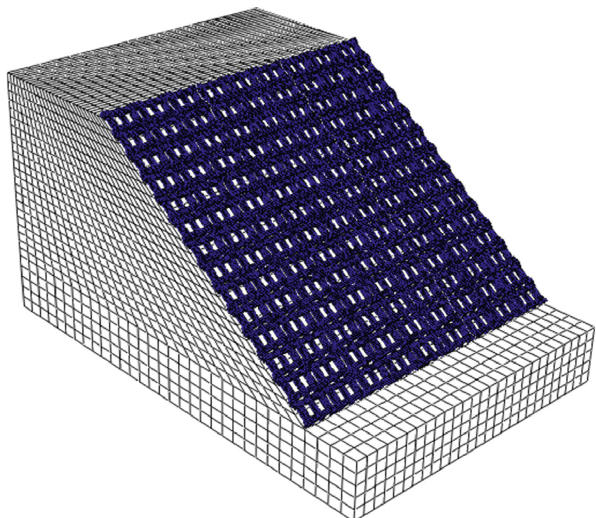
Figure 11: Finite element simulation model.